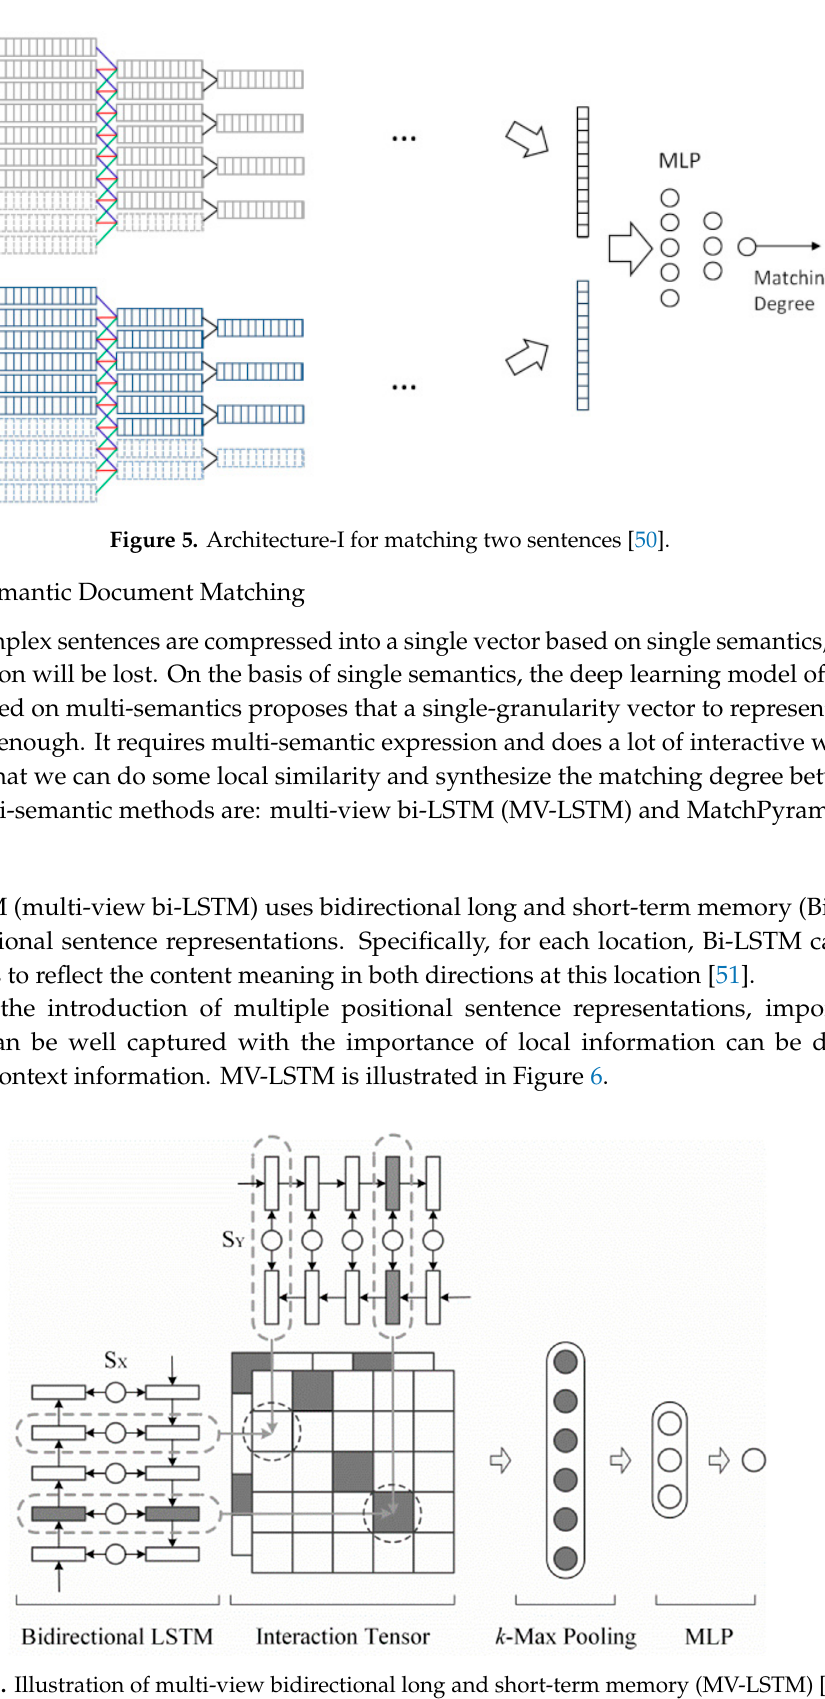
Figure 6. Illustration of multi-view bidirectional long and short-term memory (MV-LSTM) [51].